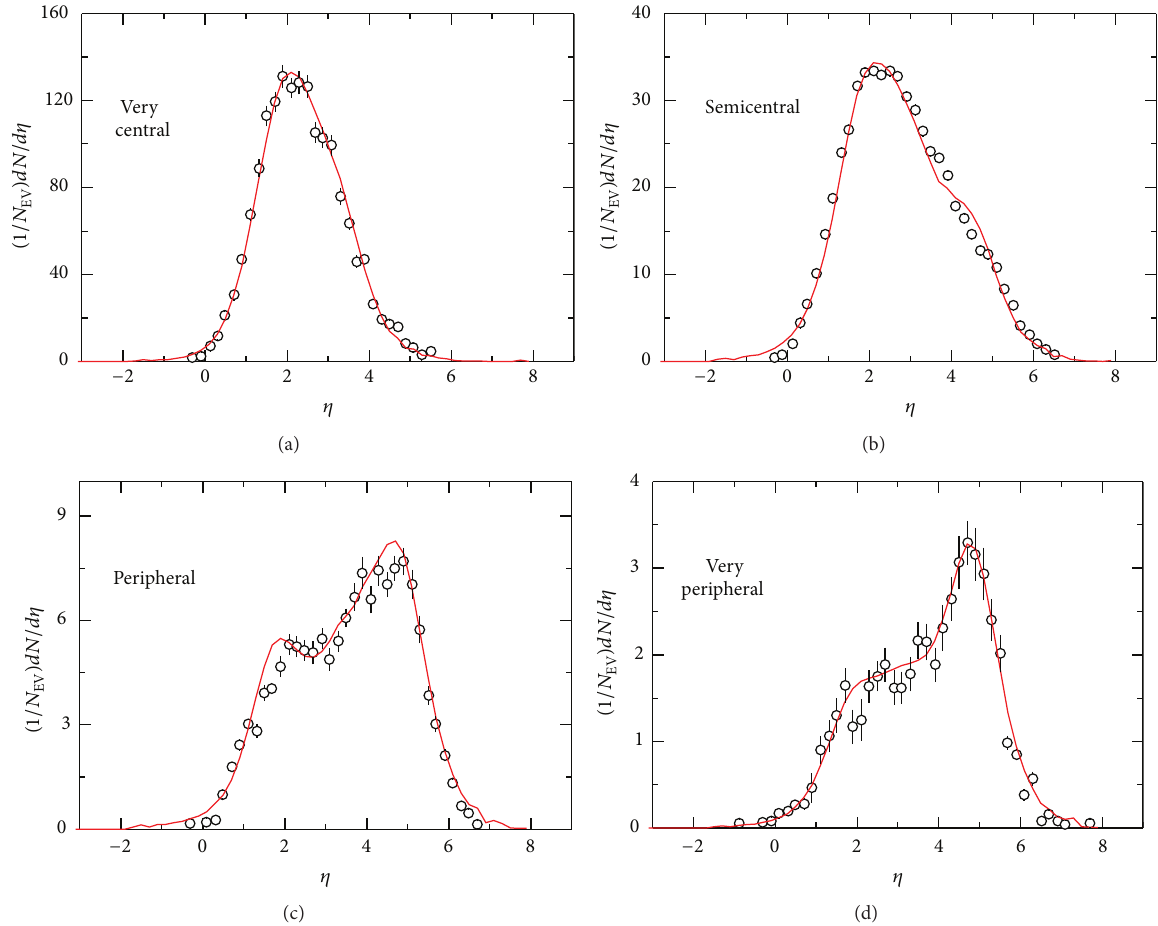
Figure 10: The same as Figure 1 but showing the results of Au-Em collisions at 𝐸 beam = 10.6𝐴 GeV, where the data are quoted in [27].